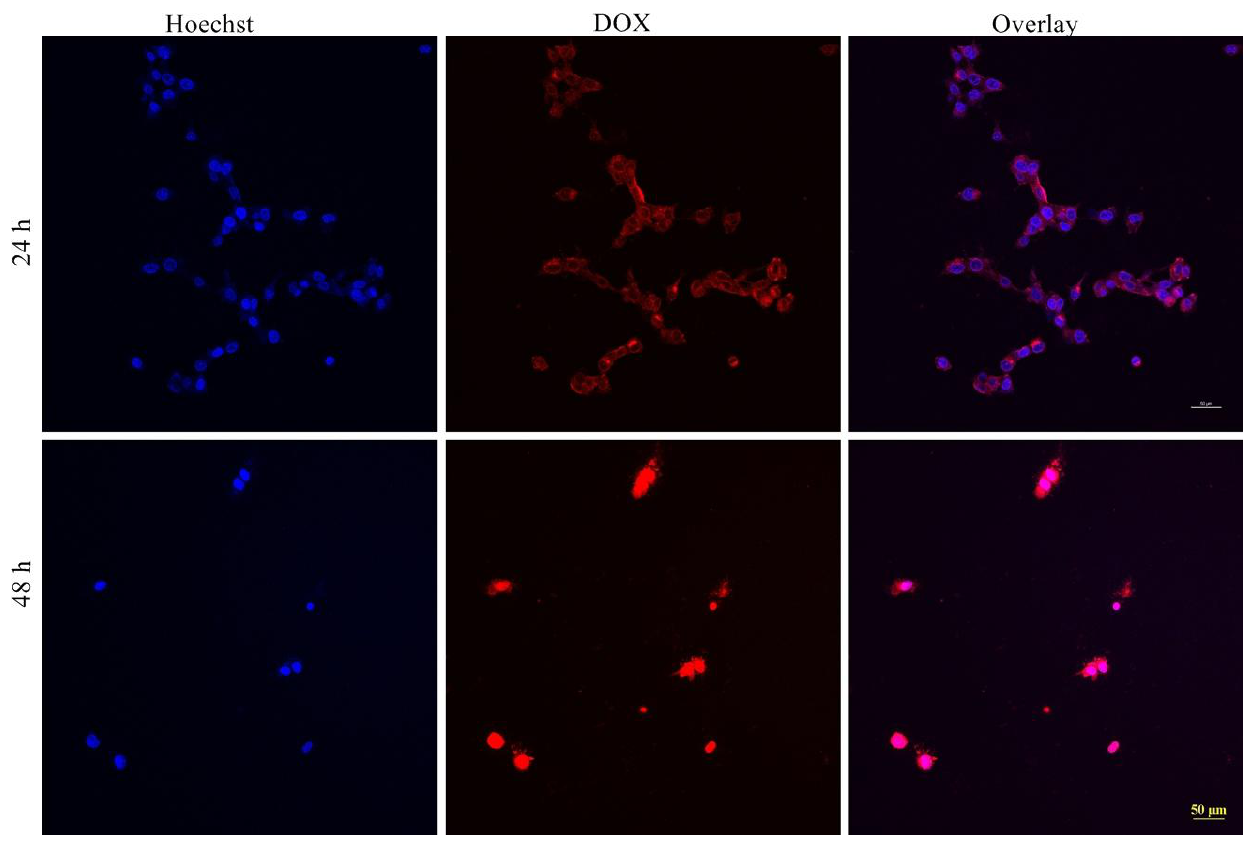
Figure 6. Confocal laser microscopy (CLSM) of MCF-7 cells incubated with